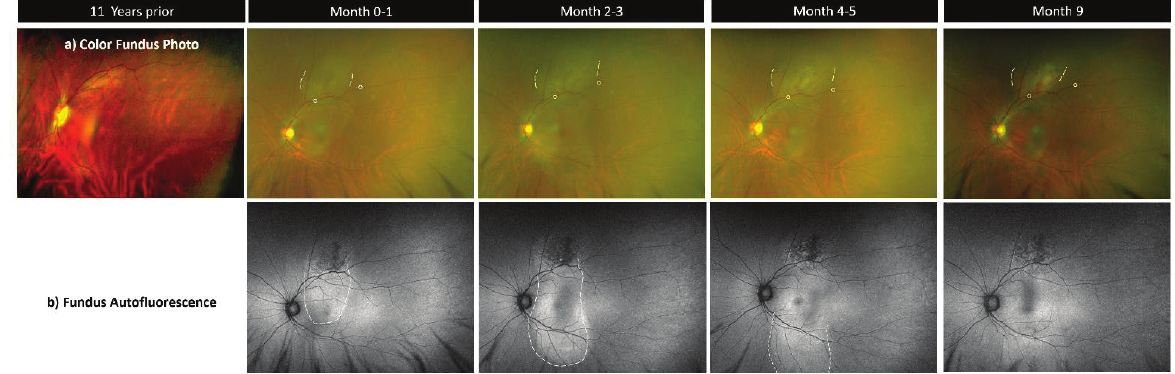
Figure 1. (a) Color fundus photography showing lateral boundaries (dotted lines) of tumor above fovea. White circles are the same bifurcation of vessels in each image. (b) Autofluorescence showing speckled pattern and extent of subretinal fluid (dotted lines).